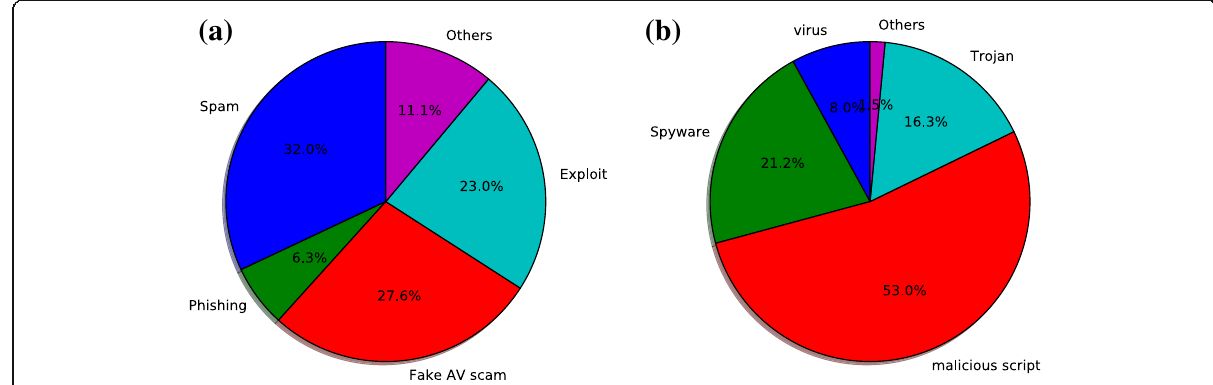
Fig. 8 Distribution of attack vectors and payloads of Bars. a Distribution of attack vectors of Bars. b Distribution of payploads of